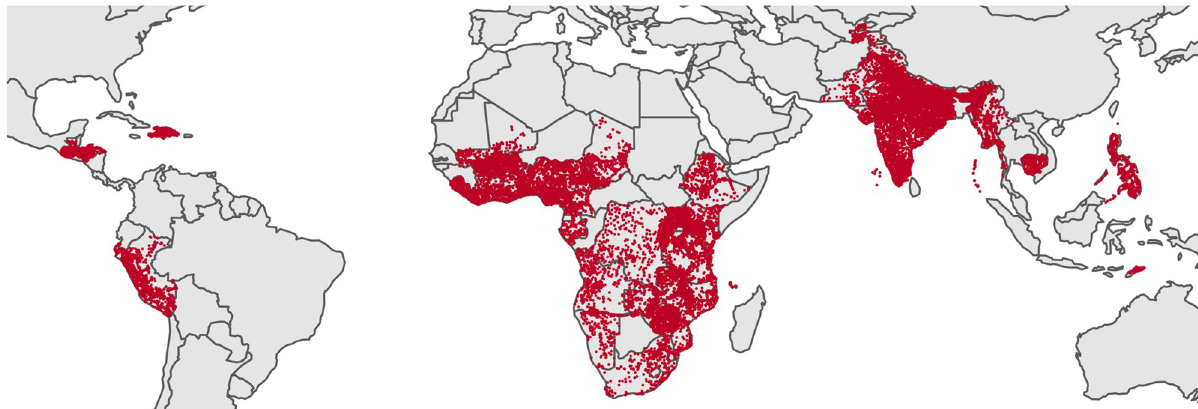
Fig 1. Study locations. Location of every DHS cluster included in the study.